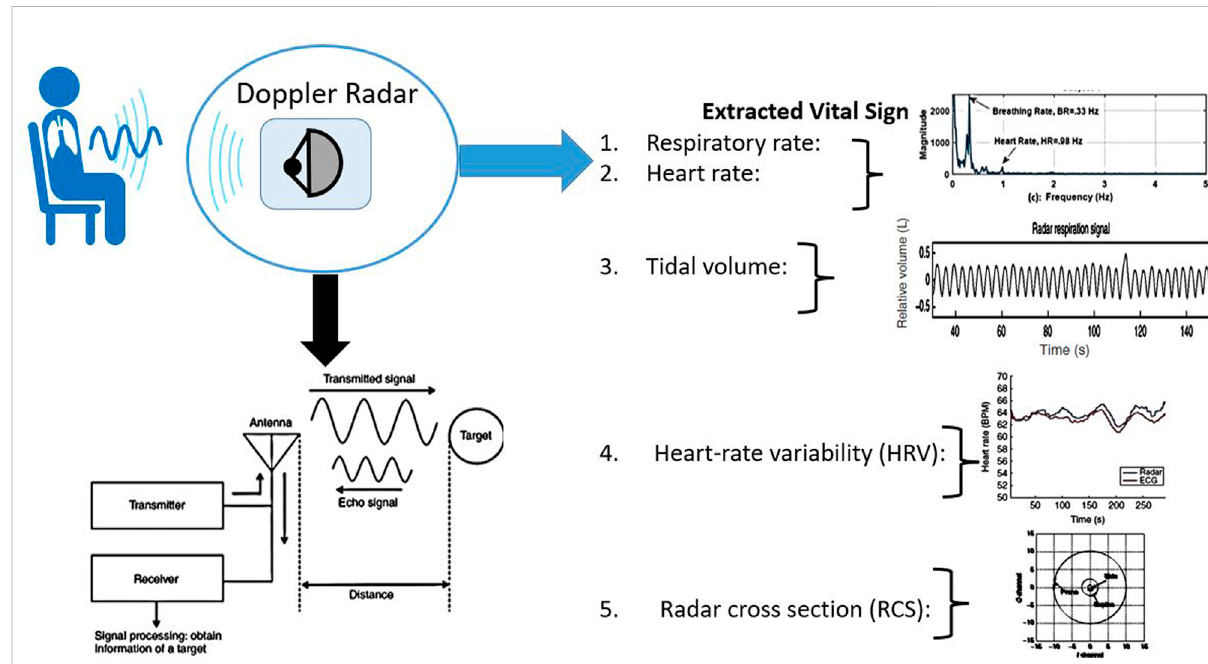
FIGURE 1 The basic principle of Radar-based non-contact physiological sensing. A typical Radar sends an electromagnetic signal and from the re fl ected echo tiny movements of the human chest ’ s surface can be tracked. Different vital sign parameters can also be extracted including breathing rate, heart rate, tidal volume, heart rate variability, and Radar cross-section (RCS). Radar circuitry components ’ typical block diagram is also shown in the fi